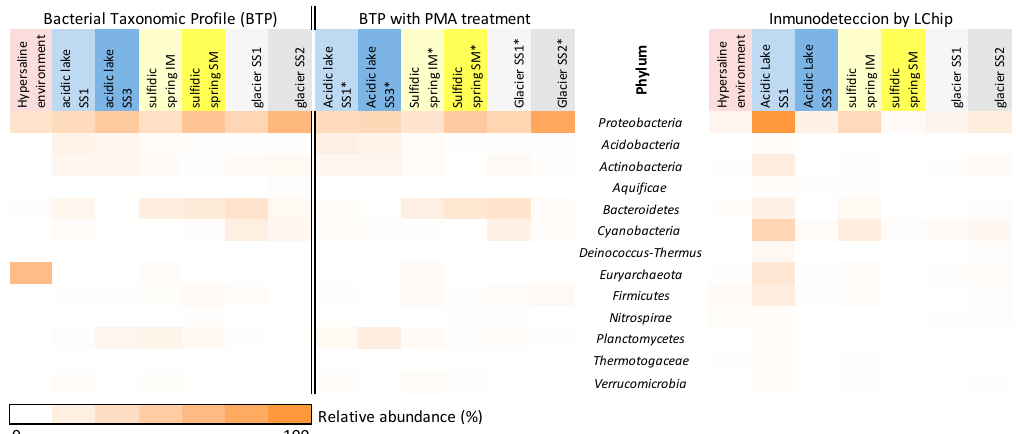
Figure 4. Comparison of bacterial abundance of the samples at phylum level. The heat maps display the relative abundance of phylum in each sample, where left panels show the universal primer set approach (samples without propidium monoazide (PMA) treatment and with PMA treatment-marked with asterisk*) and the right panel, the positive immunoreactions by the LDChip. Hypersaline environment: Boulby Mine (Bou); acidic lake SS1 and SS3 (Grænavatn Lake, IS.SS1 and IS.SS3); sulfidic spring IM and SM (Regensburg, RG.SM and RG.MSI); Glacier SS1 and SS2 (Kaunertal Glacier, G.SS1 and G.SS2). Sequences from hypersaline environment were not available for PMA treatment due to the interferences between salts and PMA